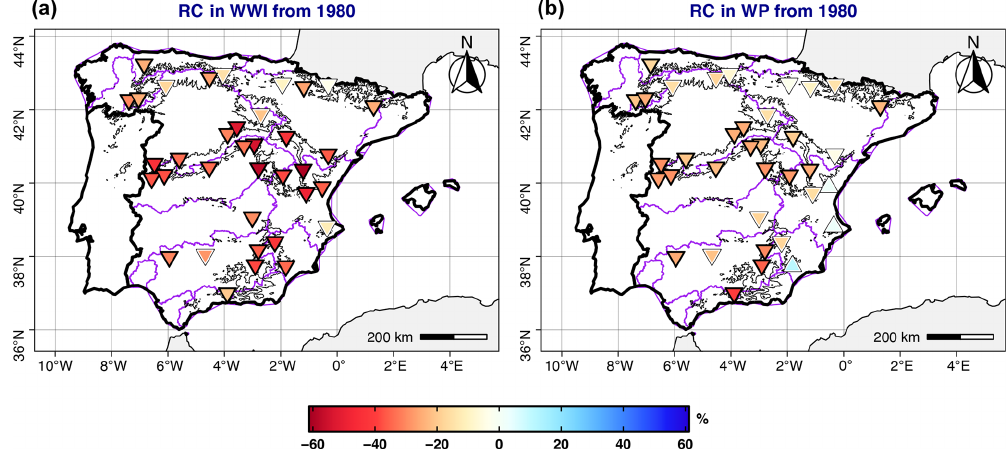
Figure 4. Panel (a) outlines the relative change (RC) in WWI since 1980, and panel (b) shows the same for WP. The RC is computed as shown in Eq. (2) (Sect. 2.2). Basically, the RC analysis compares the mean during the 1980–2018 period with the mean during the former period (1952–1979). The symbols represent positive RC (upward-pointing triangle) and negative RC (downward-pointing triangle), and a black outline indicates that the estimates are significant. Contours of orography (black) and IHB for continental Spain (purple) are also shown (see Fig.